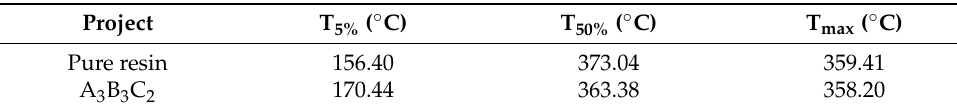
Table 10. TGA parameters before and after adding filler/ ◦ C.